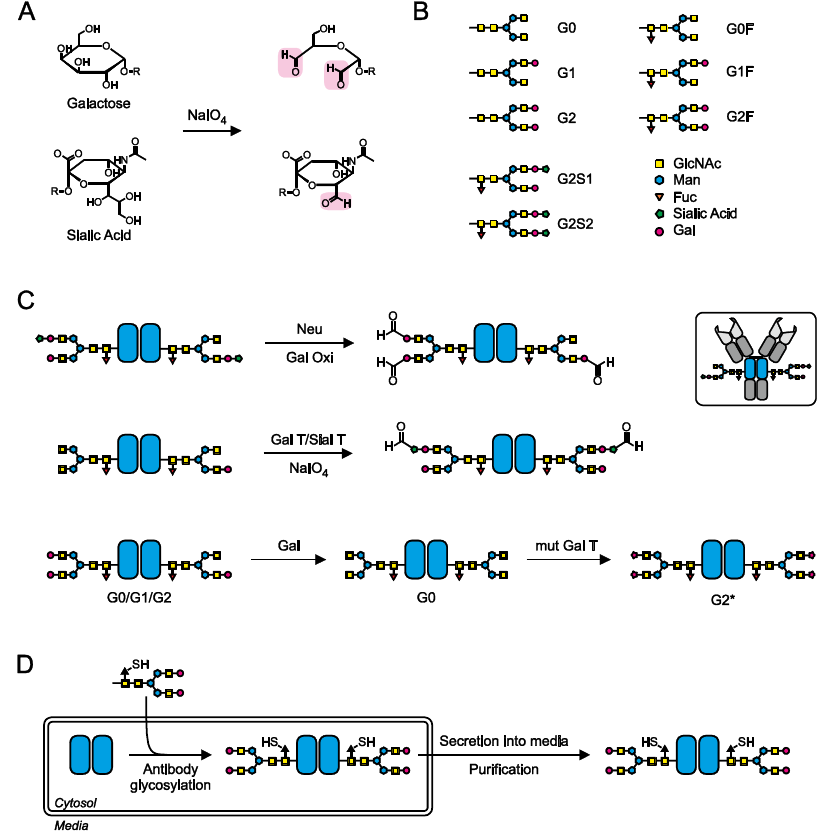
Figure 4. Different strategies to introduce bioorthogonal functionalities onto the carbohydrate moiety for site selective conjugation. ( A ) Classical chemical approaches use sodium periodate (NaIO 4 ) to oxidize cis -glycol groups of e.g., galactose or sialic acid resulting in the formation of an aldehyde functionality (red square). ( B ) Schematic representation of a selection of different glycoforms that can be found on IgGs (illustrates the heterogeneity of antibody glycosylation patterns). ( C ) Novel enzymatic methods treat the sugar residue with neuraminidase (Neu) and galactose oxidase (Gal Oxi) which results in the formation of bioorthogonal aldehyde functionalities (not homogeneous). Sequential treatment of the antibody with β1,4-galactosyltransferase (Gal T) α2,6-sialyltransferase (Sial T) yields homogeneously sialylated antibodies that can be selectively oxidized to the corresponding aldehyde functionality or used as selective bioorthogonal handle if sialic acid derivatives are used. A more recent method introduces non-natural galactose derivatives by treating the antibody with β-galactosidase (Gal) and a mutant Gal T (accepts bioorthogonal azide- or keto-galactoses) to yield homogeneous G2 glycan patterns comprising non-natural functionalities (*). ( D ) Non-canonical thio-fucose derivatives were incorporated into the glycan of antibodies by feeding the cells with the bioorthogonal sugar resulting in expressed antibodies that display thiol functionalities (not